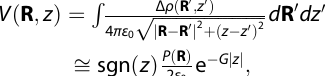
Fig. 2 Characterization of the electrostatic superlattice potential. a Schematic of a n + n multilayer, consisting of two n -layer AA ′ h-BN stacked with a parallel interface. The interface is characterized by the in-plane translation r between the two parallel BN layers. b Charge redistribution due to interlayer coupling at the parallel interface with registry r ¼ a = averaged charge density of the n + n multilayer calculated using DFT, and ρ n, t/b is that of the pristine top/bottom n -layer. Dashed vertical lines indicate atomic planes. For various thickness n considered, Δ ρ is predominantly distributed with nearly the same pro fi le on the two layers forming the interface. c Electrical polarization in the n + n multilayers, evaluated using the vacuum level difference on the two sides of multilayer directly extracted from DFT. d P as a function of r in the 2 + 2 con fi guration. The dots denote the values from the DFT-calculated Δ ρ , and the curve is the fi tting using Eq. (1). e Laterally modulated polarization P ( R ) when the interface has a rigid twist from parallel by small angle δ , and the resultant electrostatic superlattice potential V ( R , z ) on constant z plane (from Eq. (2), c.f. text). V ( R ) is shown at three vertical distance from the interface which, for the example of δ = 1.5° (period b = 9.6 nm), corresponding to thickness of n = 2, 4, and 6 layers,